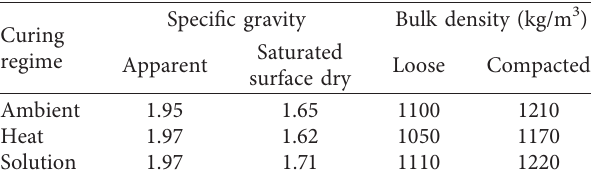
Figure 3: Particle size distribution of produced aggregates along with IS 383–2016 limits. Table 4: Average specific gravity and bulk density of artificial fly ash aggregates subjected to different curing